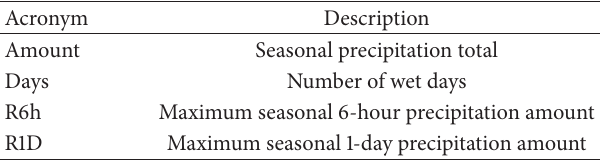
Table 1: Acronyms used for precipitation